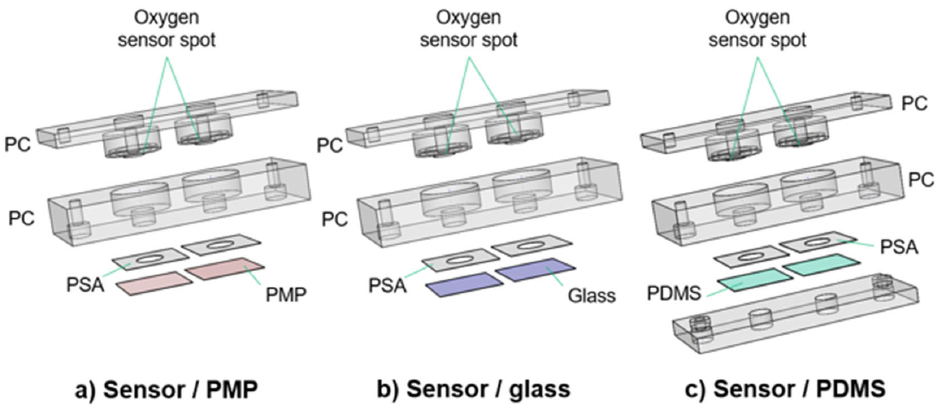
Figure 2. Culture chamber devices with integrated oxygen sensors. Three different designs of the culture chamber device. The main device is the sensor/PMP device, and the two remaining devices were necessary to obtain adequate controls for the experiments with PMP. Each device has in total four ( a , b ) or five ( c ) layers. From the top, the device layers are (1) the lid milled in PC ( a – c ); (2) the baseplate milled in PC ( a – c ); (3) PSA ( a – c ); (4) PMP film ( a ), glass coverslip ( b ) or PDMS film ( c ); and (5) the clamping plate ( c ). See Section 2.2.1 for details. These devices were utilized for oxygen